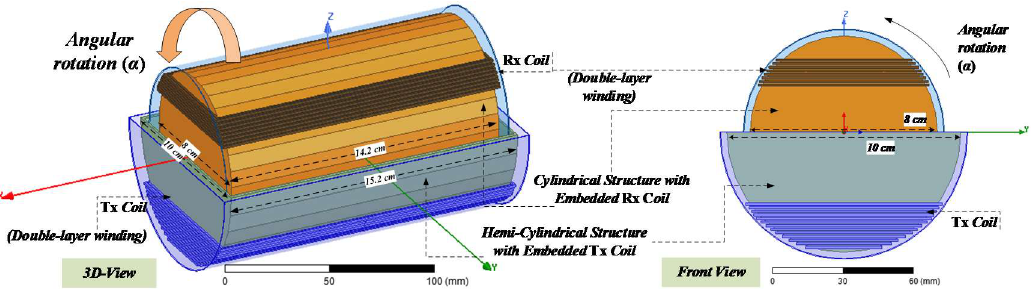
Figure 1. Cylindrical-joint structure of wireless-power-transfer (WPT) system (rotation-free structure).